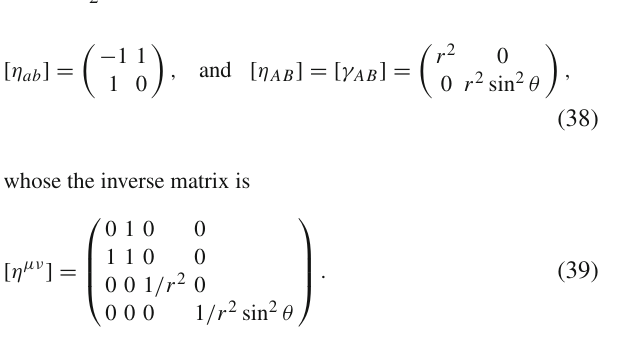
( r ) . The shaded region indicates where the focusing condition is valid. On left, it is obtained for C Fig. 1 Plots of f ± 0 it was chosen C 0 , C 1 > 0. On right, it was set C 0 < 0 and C 1 > 0. For both C 0 , C 1 < 0, f ( r ) is purely